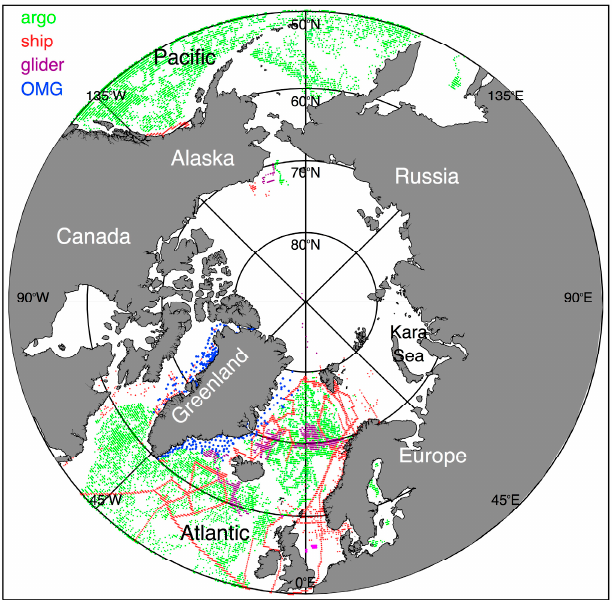
Figure 1. Location where in situ salinity are collected within 5 m from surface by Argo float (green), ship (red), glider (purple), and OMG AXCTD (blue) during the three years from April 2015 to March 2018.